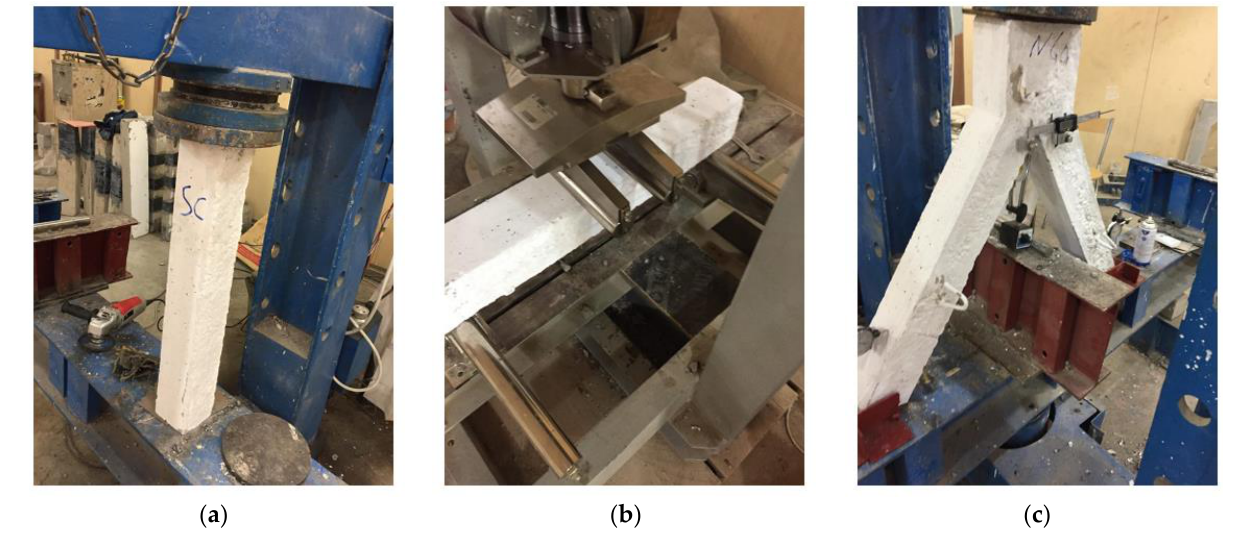
Figure 5. Test setups for ( a ) vertical column test, ( b ) beam test, ( c ) V-shaped column test.